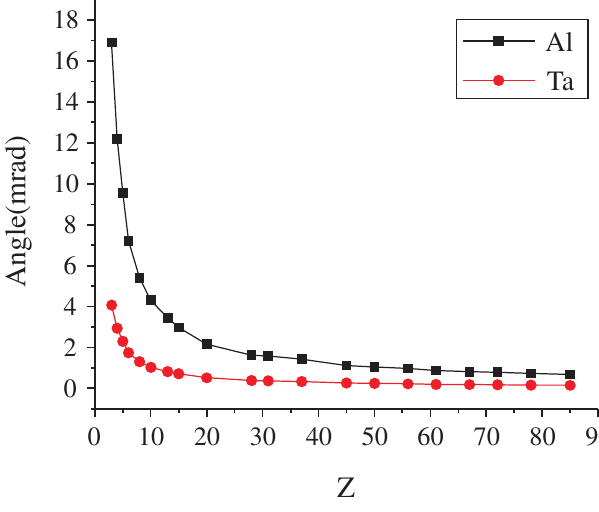
FIG. 6. (Color) Optimal angle needed to maintain linear achro- maticity for various beams of 200 MeV = u energies as a function of Z and two different wedge materials of 30% range thickness in all cases.